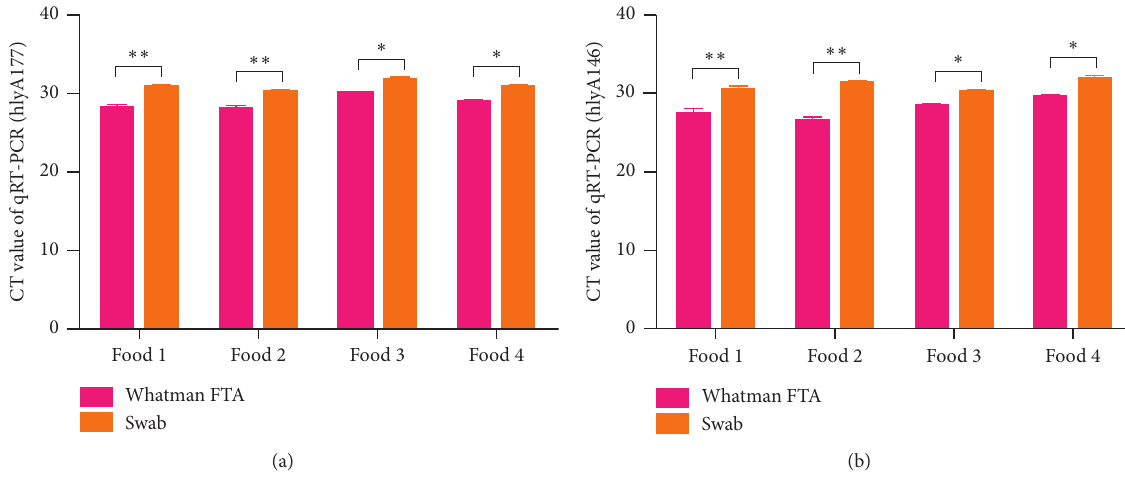
Figure 5: Detection of Listeria monocytogenes genes in food samples containing Listeria monocytogenes contamination by RT-qPCR collected using Whatman FTA cards and swabs. (a) Expression level of the hly177 gene in a serially diluted environmental strain of Listeria monocytogenes samples on Whatman FTA cards and swabs and detected by RT-qPCR ( n � 6, ∗ P < 0 . 05 and ∗∗ P < 0 . 01). (b) Expression level of the hly146 gene in an environmental strain of Listeria monocytogenes samples on Whatman FTA cards and swabs detected by qRT-PCR ( n � 6, ∗ P < 0 . 05 and ∗∗ P < 0 . 01). RT-qPCR: reverse transcription-quantitative PCR; FTA: Flinders Technology